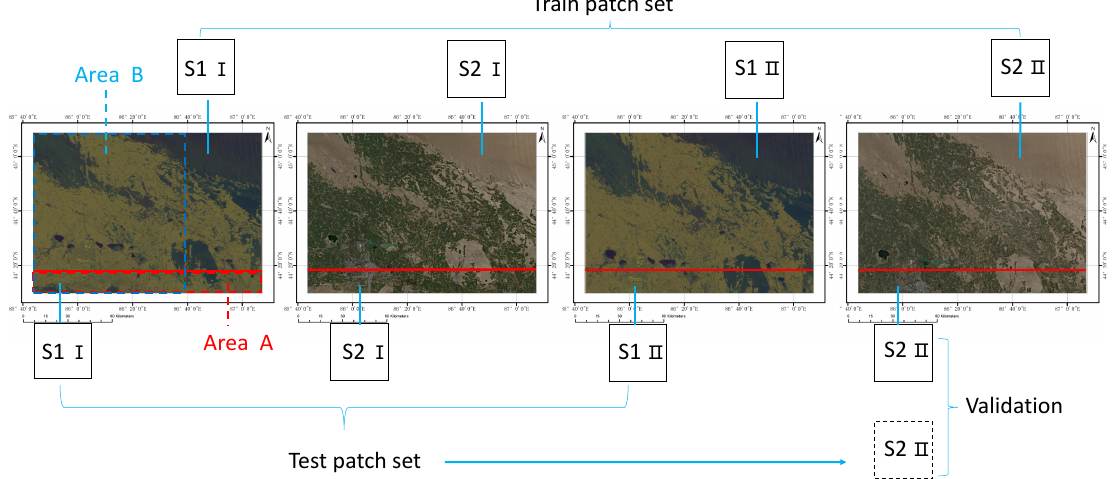
Figure 2. The train patch set and test patch set (the solid line box: real data, the dotted line box: simulated data, Area A: validation area for spatial transfer, Area B: validation area for time